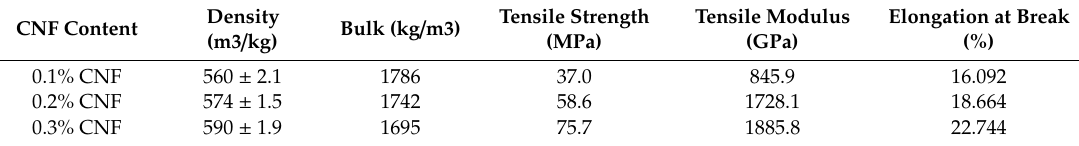
Table 2. Mechanical properties of CNF nanopapers with di ff erent CNF